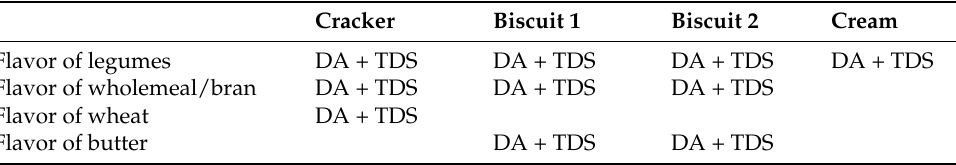
Table 2. List of attributes evaluated in descriptive analysis (DA) and temporal dominance of sensa- tions